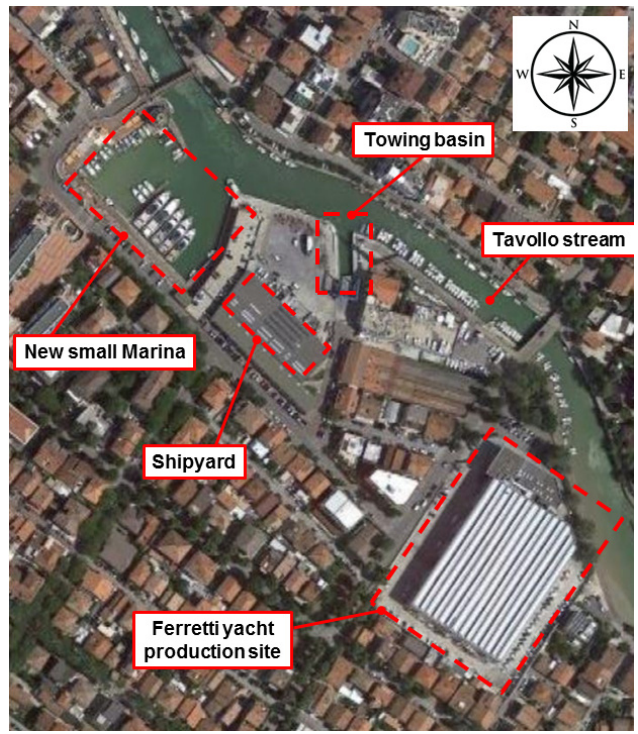
Figure 2. Aerial view of the new small marina area.